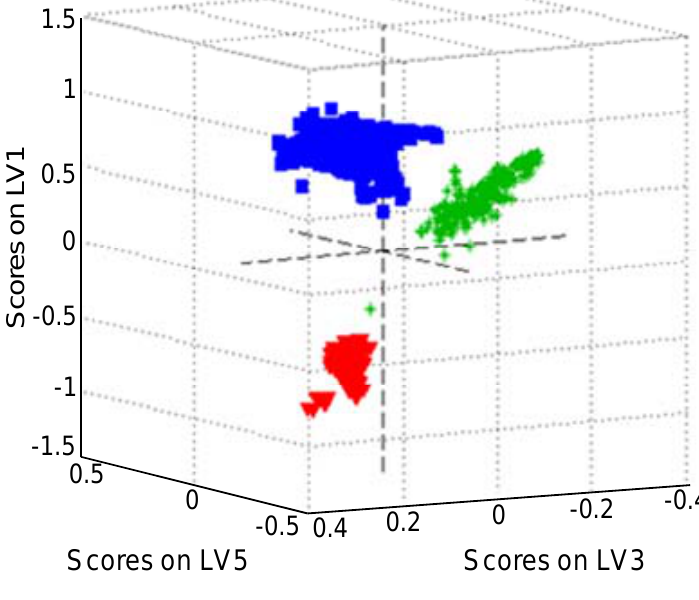
Figure 5. A three-dimensional latent variable plot for human blood ( red ), semen ( blue ) and saliva ( green ) samples based on the first, third and fifth latent variables (LV).